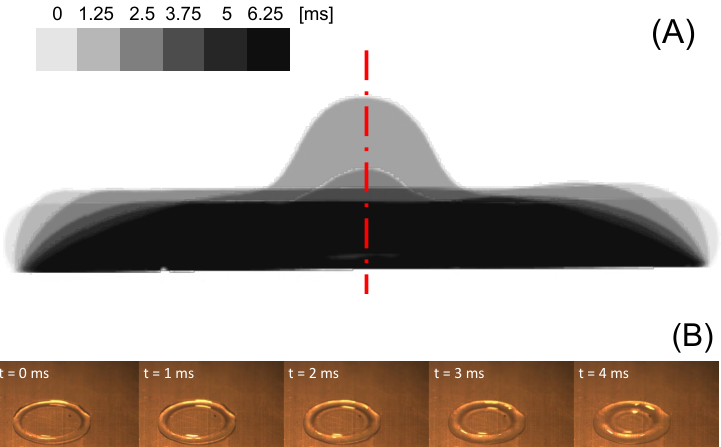
Figure 3. ( A ) Stroboscopic side view of a PEO aqueous solution drop ( D 0 ≈ 3 mm) impacting on a PTFE surface at the beginning of recoil after maximum spreading ( c = 200 ppm; We = 45; D max / D 0 ≈ 2.2). The gray levels in region near the contact line correspond to the time since maximum spreading. ( B ) Top view of the same drop showing the toroidal rim during the first 4 ms of recoil after maximum